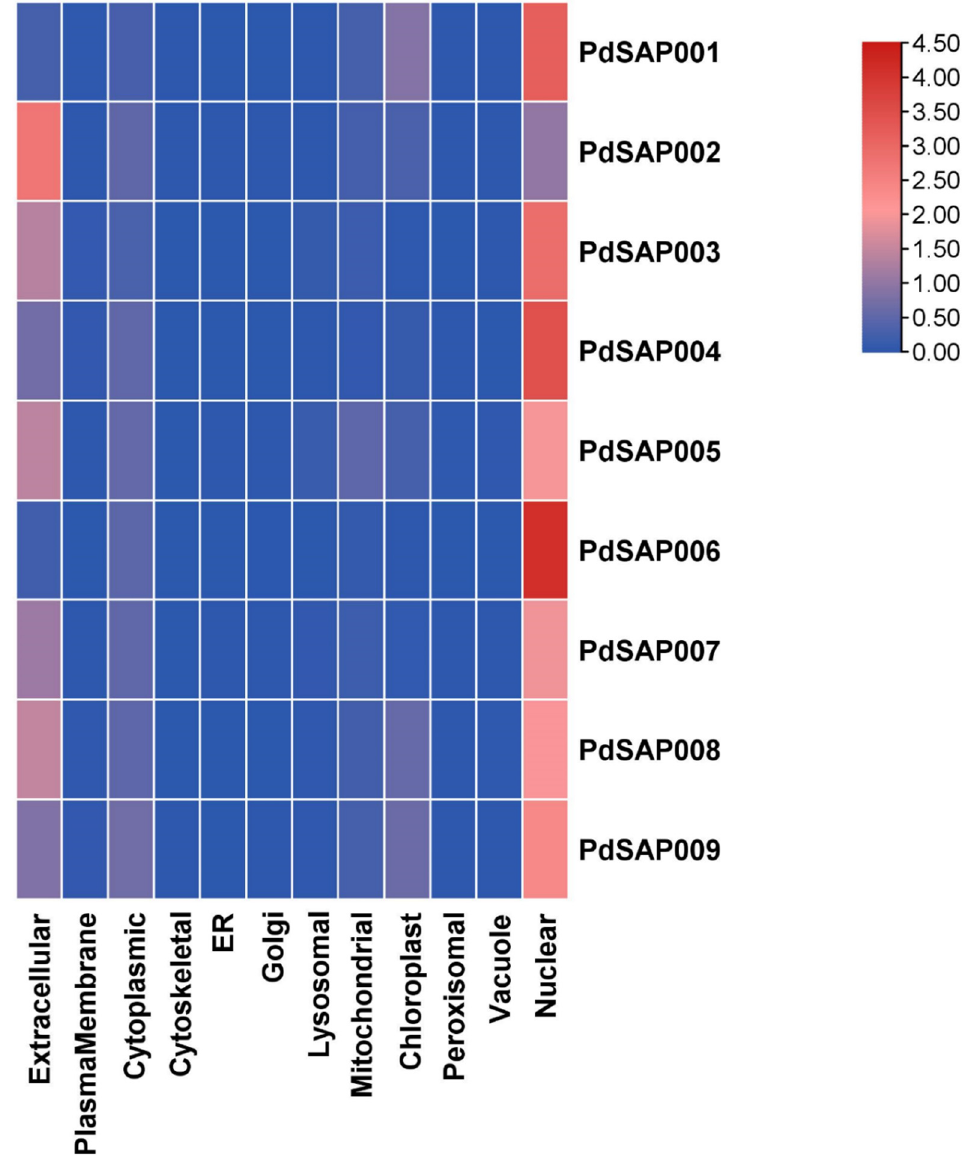
Figure 8. Subcellular localization of PdSAP gene family. Heatmap of PdSAP is shown. Majority of PdSAP genes are in nuclear region.